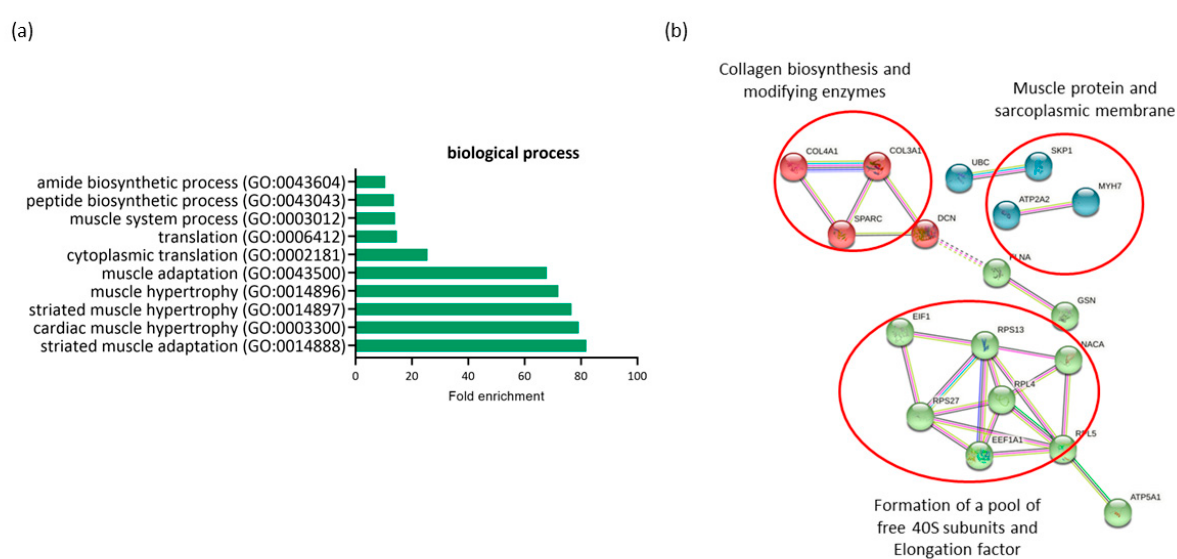
Figure 3. Profiling of differentially expressed genes (DEGs) of non-diabetic continent women (ND-C) in comparison with gestational diabetic and incontinent women (GDM-I). ( a ) Biological processes identified for up- and down regulated genes. Enrichment was defined as the 10 most significant terms according to the highest scores and p -values (<0.05). ( b ) Protein–protein interaction network representing DEGs. The interaction map was generated using STRING with clusters, a high confidence of 0.7, and all criteria for linkage (co-occurrence, co-expression, experiments, neighborhood, databases, text-mining, and homology). The genes used in this network are listed in the Supplemental Table S1.